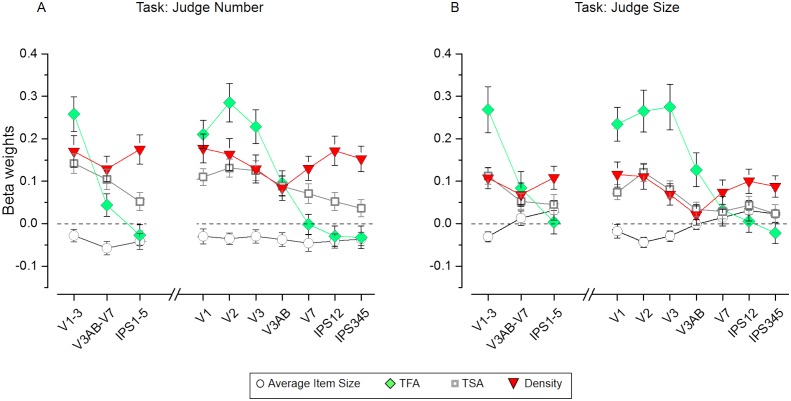
Results of the representational similarity analysis for a model including all the non-numerical dimensions only (i.e. average item size, total field area, total surface area and density).Beta weights obtained from the RSA multiple regression for average item size (circles), total field area (TFA, diamonds), total surface area (TSA, squares) and density (Density, red triangles) for the number (A) and size (B) task. The beta estimates for these non-numerical features were not differentially affected by task across ROIs, as demonstrated by the not significant triple interaction between ROI, task and dimension both for the three large regions: (F(4.12,78.24) = 1.11, p = 0.36) as well as for the individual regions (F(5.66,107.50) = 0.88, p = 0.50). However the interaction between task and dimension was significant both for the three large regions: (F(2.13,40.42) = 3.65, p = 0.03) as well as for the individual regions (F(2.07,39.39) = 3.32, p = 0.04). When quantifying the changes in beta weights across ROIs and tasks for each dimension separately, the main effect of task was significant for average item size for the three large regions (F(1,19) = 7.02, p = 0.02) and but not for the individual regions (F(1,19) = 3.97, p = 0.06), however the near zero beta values estimated for this dimension make this result difficult to interpret. The main effect of task was significant for density for the three large regions (F(1,19) = 6.69, p = 0.02) and for the individual regions (F(1,19) = 7.13, p = 0.01). The main effect of task for the other dimensions was not significant for total field area (for the three large regions: F(1,19)=0.61, p = 0.44; for the individual regions: F(1,19) = 0.51, p = 0.48) and for total surface area (for the three large regions: F(1,19) = 2.04, p = 0.17; for the individual regions: F(1,19) = 2.66, p = 0.12). Data points show mean beta weights across subjects (n = 20) ± standard error of the mean (SEM). P-values testing the significance of the beta coefficients for each dimension and ROI are reported in Supplementary file 6.